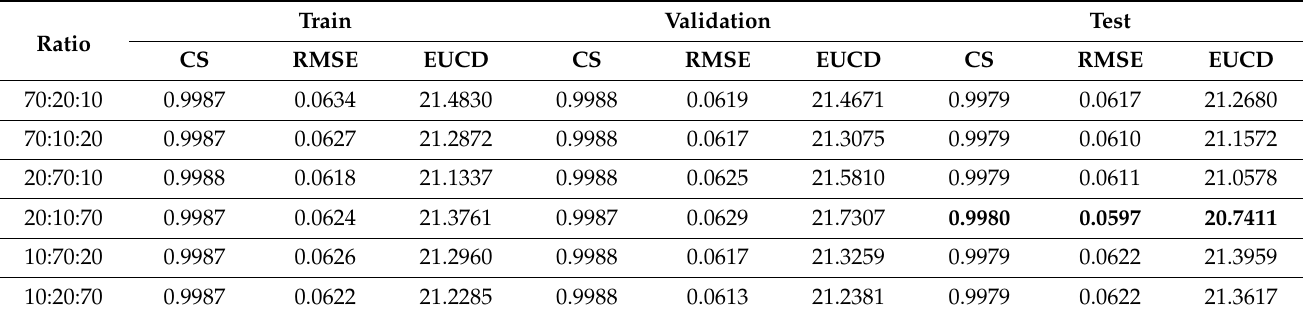
Table 5. Cross validation for ablation study of the ConvLSTM-SA